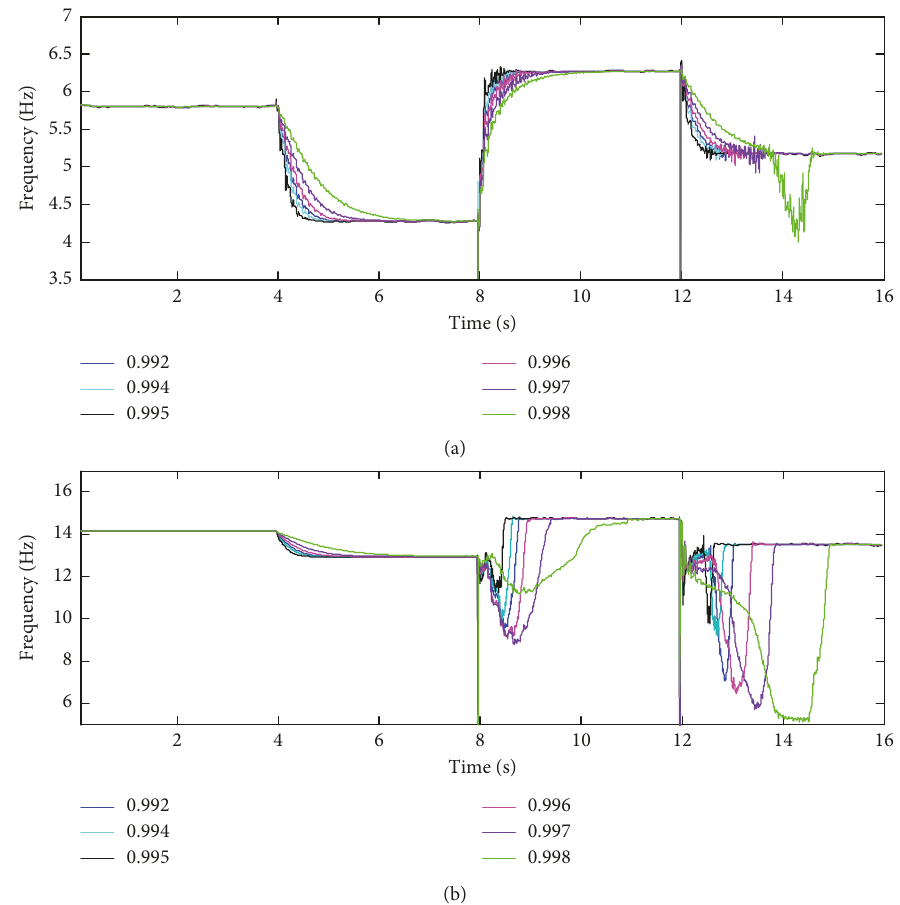
Figure 8: Frequency ( f 1 , f 2 ) identification results of simulation case 1 under different forgetting factors (SNR (cid:29) 40dB): (a) mode 1; (b) mode 2.